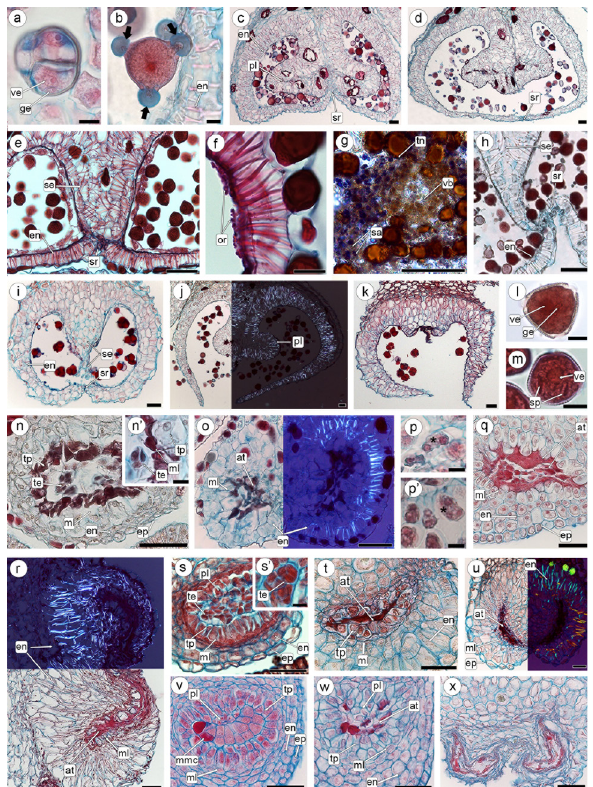
Figure 3. Cross section of anthers with pollen grains (a-i) and in a dehiscence stage (j-m), and cross section of anthers of FPF in developmental arrest stages. a , Randia heteromera (FSF). b-d, j, Tocoyena formosa (PF). e-g,